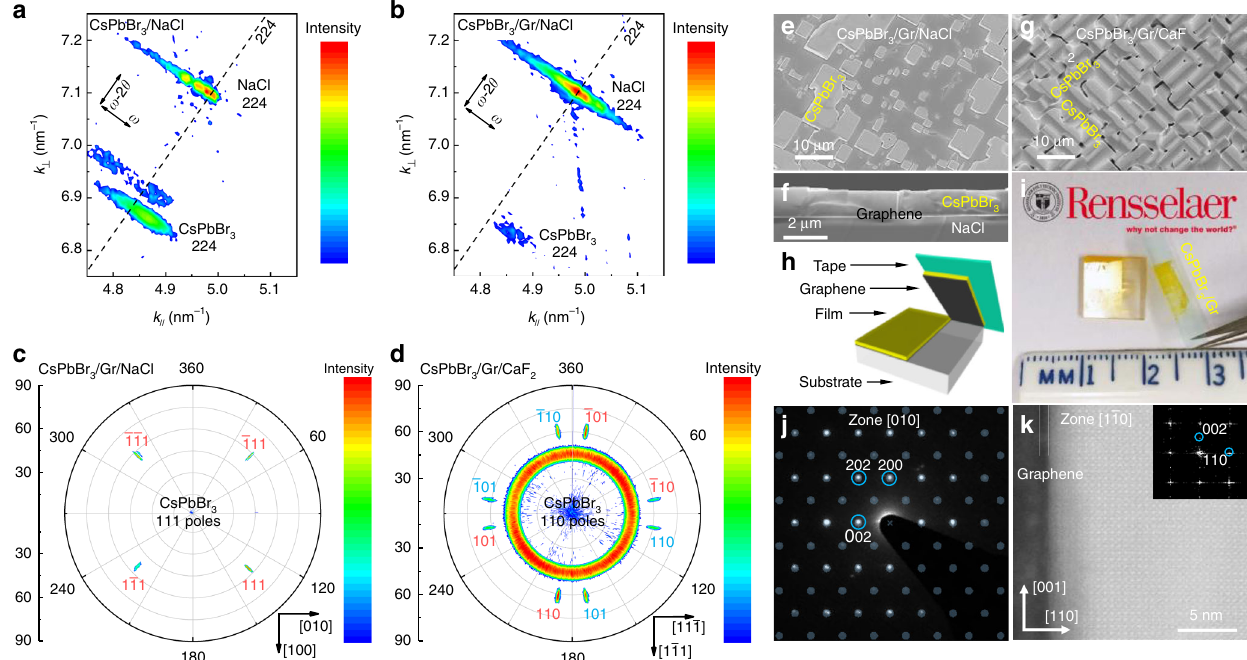
Fig. 1 Structure and morphology analysis of remote epitaxial CsPbBr 3 . a RSM of 224 peaks for CsPbBr 3 thin fi lm and NaCl from ionic epitaxy (CsPbBr 3 / NaCl). b RSM of 224 peaks for CsPbBr 3 fl akes and NaCl from remote epitaxy (CsPbBr 3 /Gr/NaCl). c X-ray pole fi gure of CsPbBr 3 111 from CsPbBr 3 /Gr/ NaCl. d X-ray pole fi gure of CsPbBr 3 110 from CsPbBr 3 /Gr/CaF 2 . e SEM image of remote epitaxial CsPbBr 3 fl akes on Gr/NaCl. f Cross-sectional SEM image of the remote epitaxial CsPbBr 3 thin fi lm on Gr/NaCl. g SEM image of remote epitaxial CsPbBr 3 triangular prisms on Gr/CaF 2 . h Schematic illustration of the exfoliation process on the remote epitaxial sample. i Photograph of the as-grown remote epitaxial thin fi lm and exfoliated thin fi lm. j Diffraction pattern of remote epitaxial CsPbBr 3 (white dots) with simulated pattern on it (transparent bluish dots). k Cs-corrected STEM image of remote epitaxial CsPbBr 3 and FFT in the inset. ( a – d are indexed by pseudocubic structure to simplify the analysis, k and j are indexed by CsPbBr 3 orthorhombic roughness of 0.9 nm and 0.4 nm at 3 μ m lateral scale, respectively.